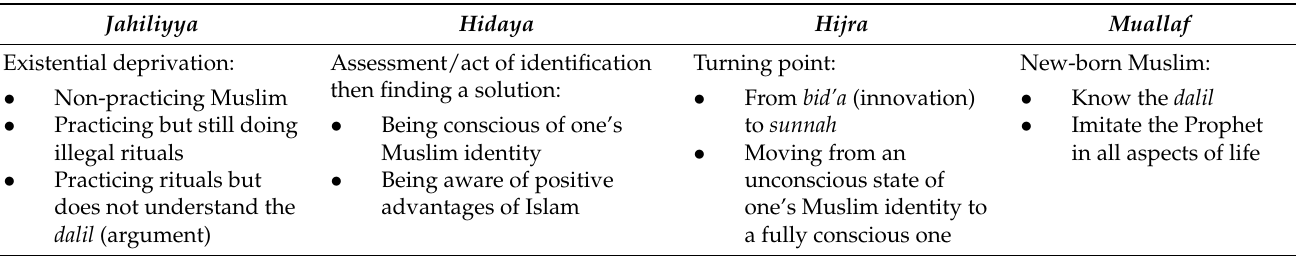
Table 3. Sequences of adaptation to Salafism and its equivalent condition according to relative deprivation